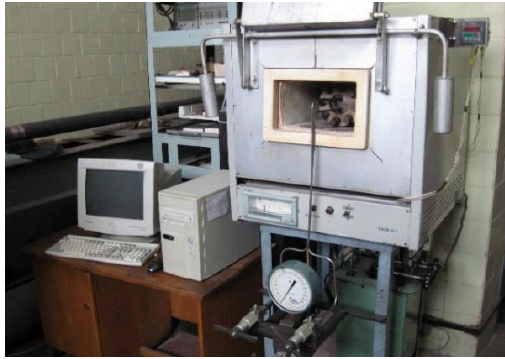
Figure 4. Installation for hydrogen-charging of samples.